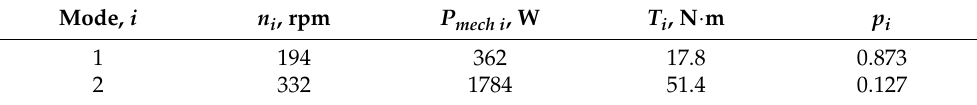
Table 2. Substituting two-mode